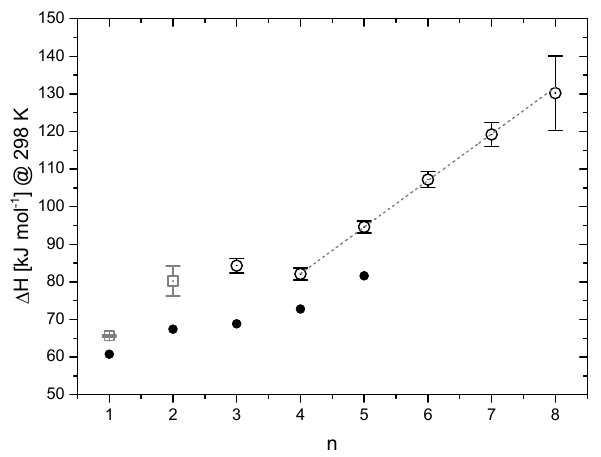
Figure 9. Enthalpies for all PEGs. Open circles: this study; open squares: Chickos and Acree Jr. (2003). Filled circles: computational predictions from this study. Dashed line is a fit through the data of PEG4 to